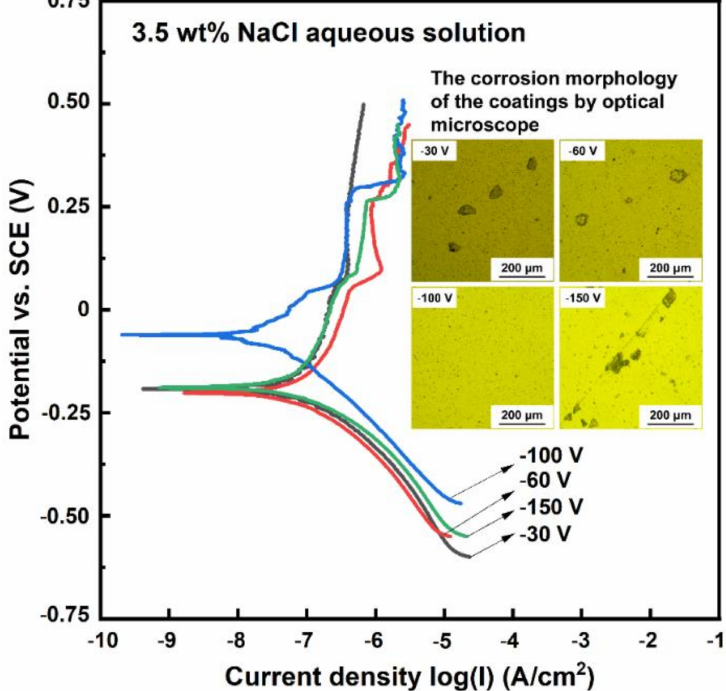
Figure 13. Potentiodynamic polarization curves of coatings deposited at various V s